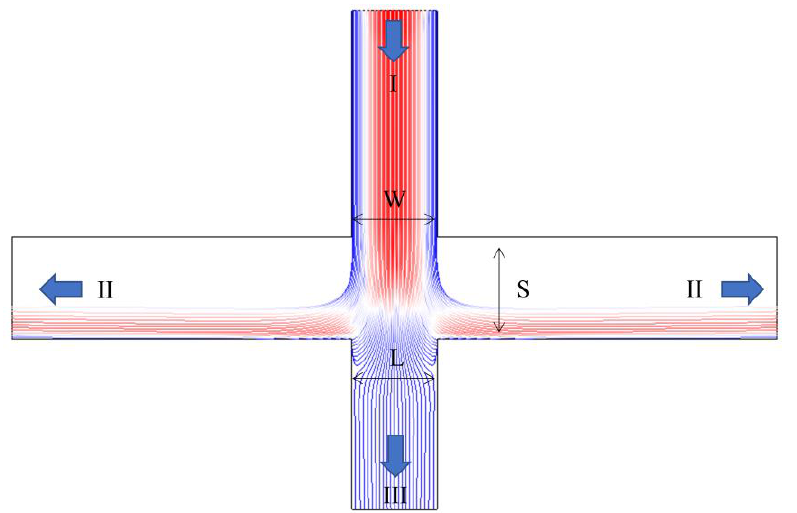
Figure 1. Particle streamline distribution of VI. The particles enter the interior of the VI through an accelerating jet (I), the fine particles follow the fluid motion to the major flow outlet (II), and the relatively large particles maintain a linear motion due to their own inertia to the minor flow outlet (III). The acceleration nozzle width (W), the minor flow channel width (L), and the distance from the jet to the plate (S) are the key parameters for designing the VI. Since the VI can be used as an aerosol particle separator, its performance is evaluated using the collection efficiency (CE) and wall loss (WL). CE is defined as the ratio of the number of particles exiting the major flow to the sum of the number of particles exiting the major flow and the minor flow, and WL is defined as the ratio of the number of particles lost inside the VI to the number of inlet particles [15]. The equations for CE and WL are shown below.